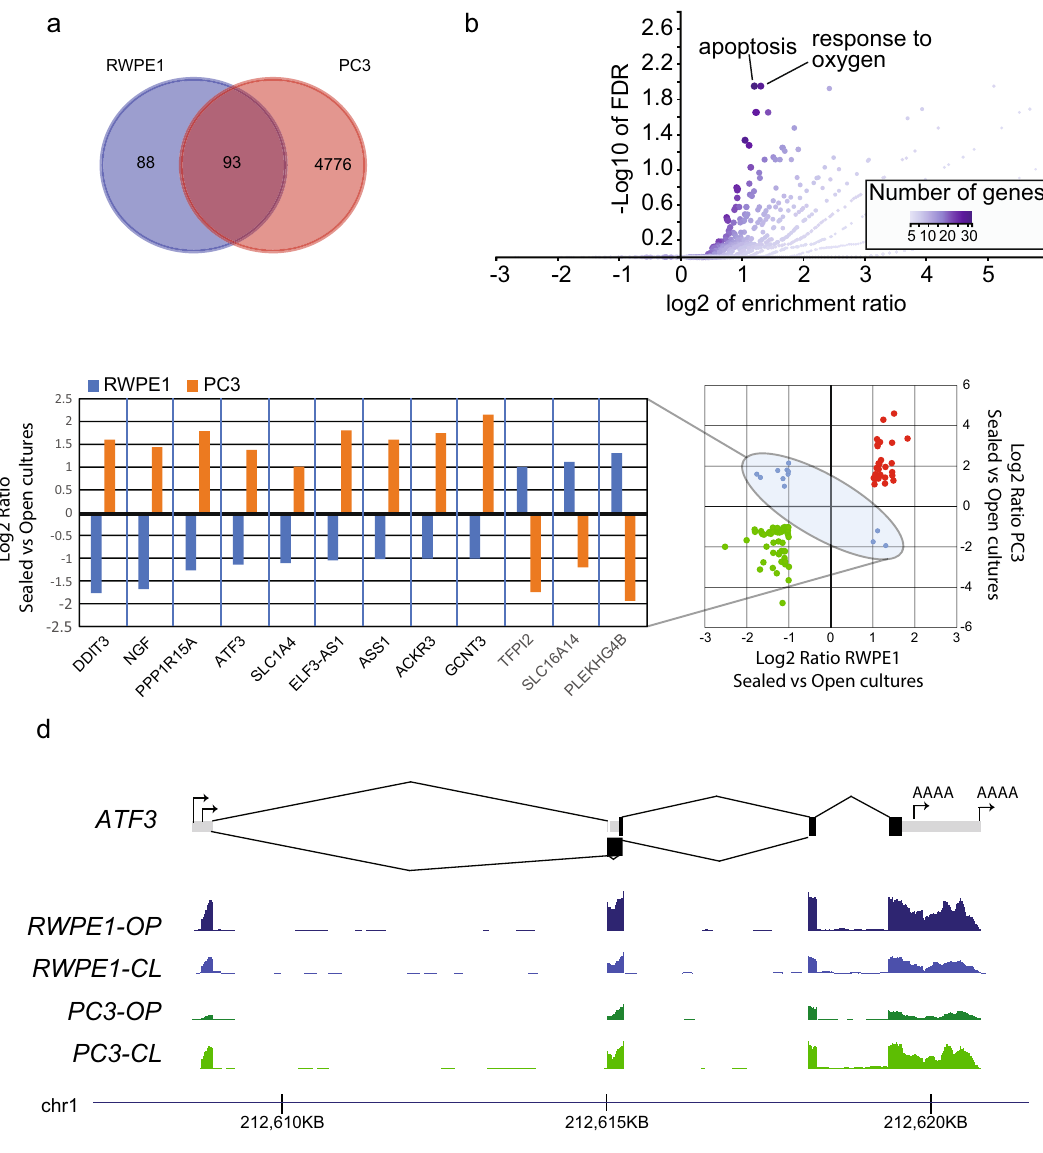
Figure 5. RNA-sequencing analysis of RWPE1 and PC3 cells cultured under sealed and unsealed conditions. ( a ) Number of differentially expressed genes in sealed versus unsealed culture conditions for RWPE1 and PC3 cells. ( b ) Gene ontology enrichment analysis of differentially expressed genes in RWPE1 cells cultured under sealed versus unsealed conditions. ( c ) Gene expression levels of genes differentially expressed in RWPE1 and PC3 cells cultured under sealed versus unsealed conditions. ( d ) ATF3 gene structure and transcriptional profiles for RWPE1 and PC3 cells cultured under sealed (CL) and unsealed (OP)